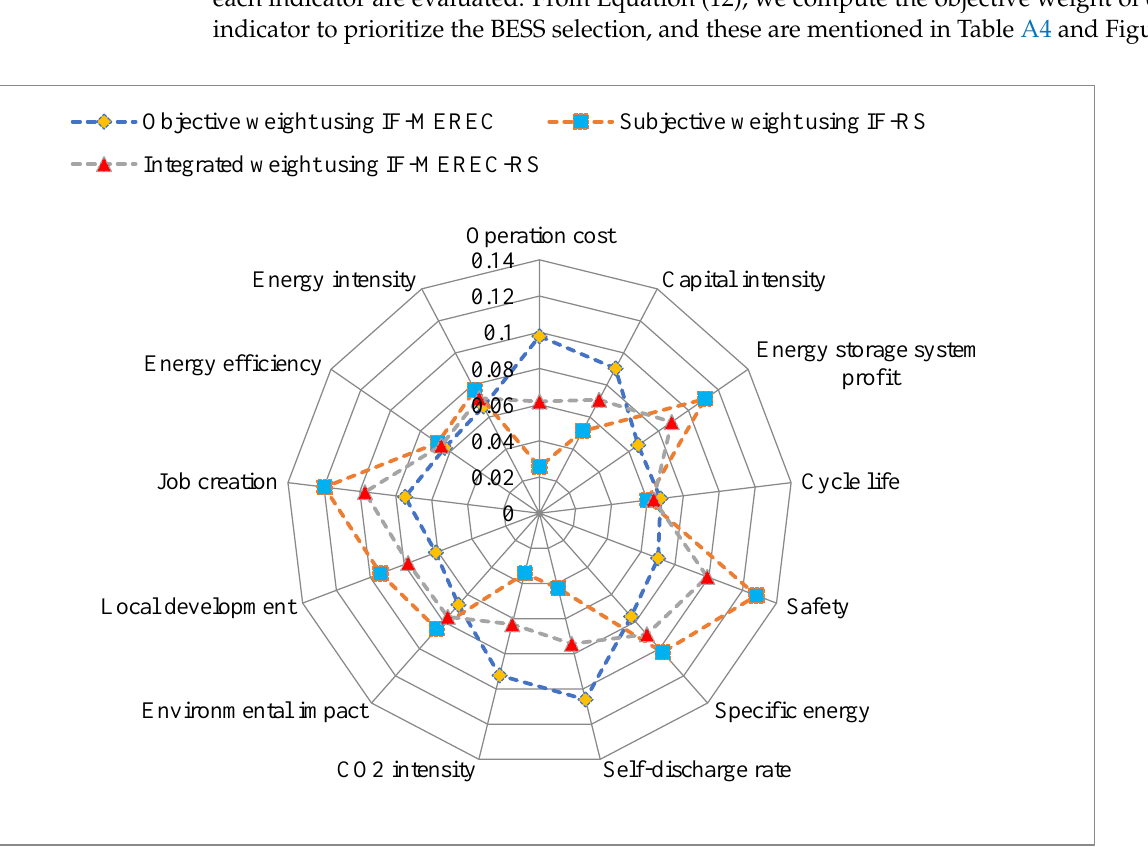
Figure 2. Weight of indicators for prioritizing BESS using the IF-MEREC-RS.